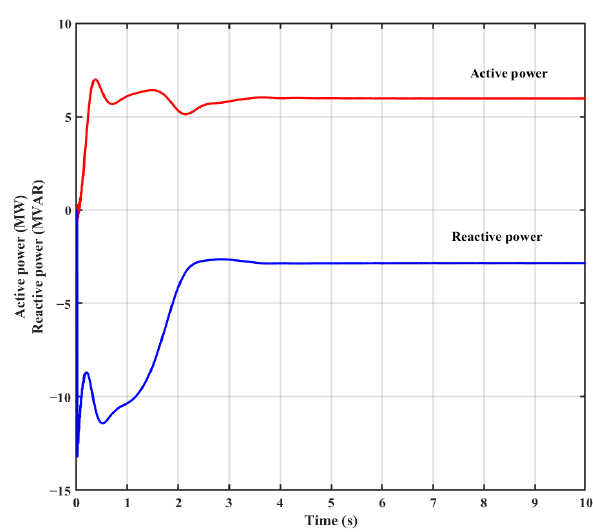
Figure 18. The power output of the wind farm.